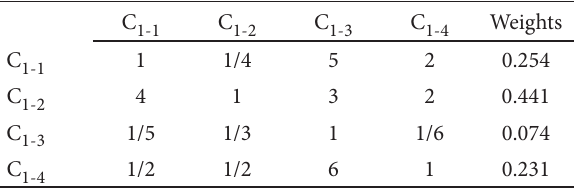
Table 7. Pairwise comparison matrix for Environmental factors and their weights